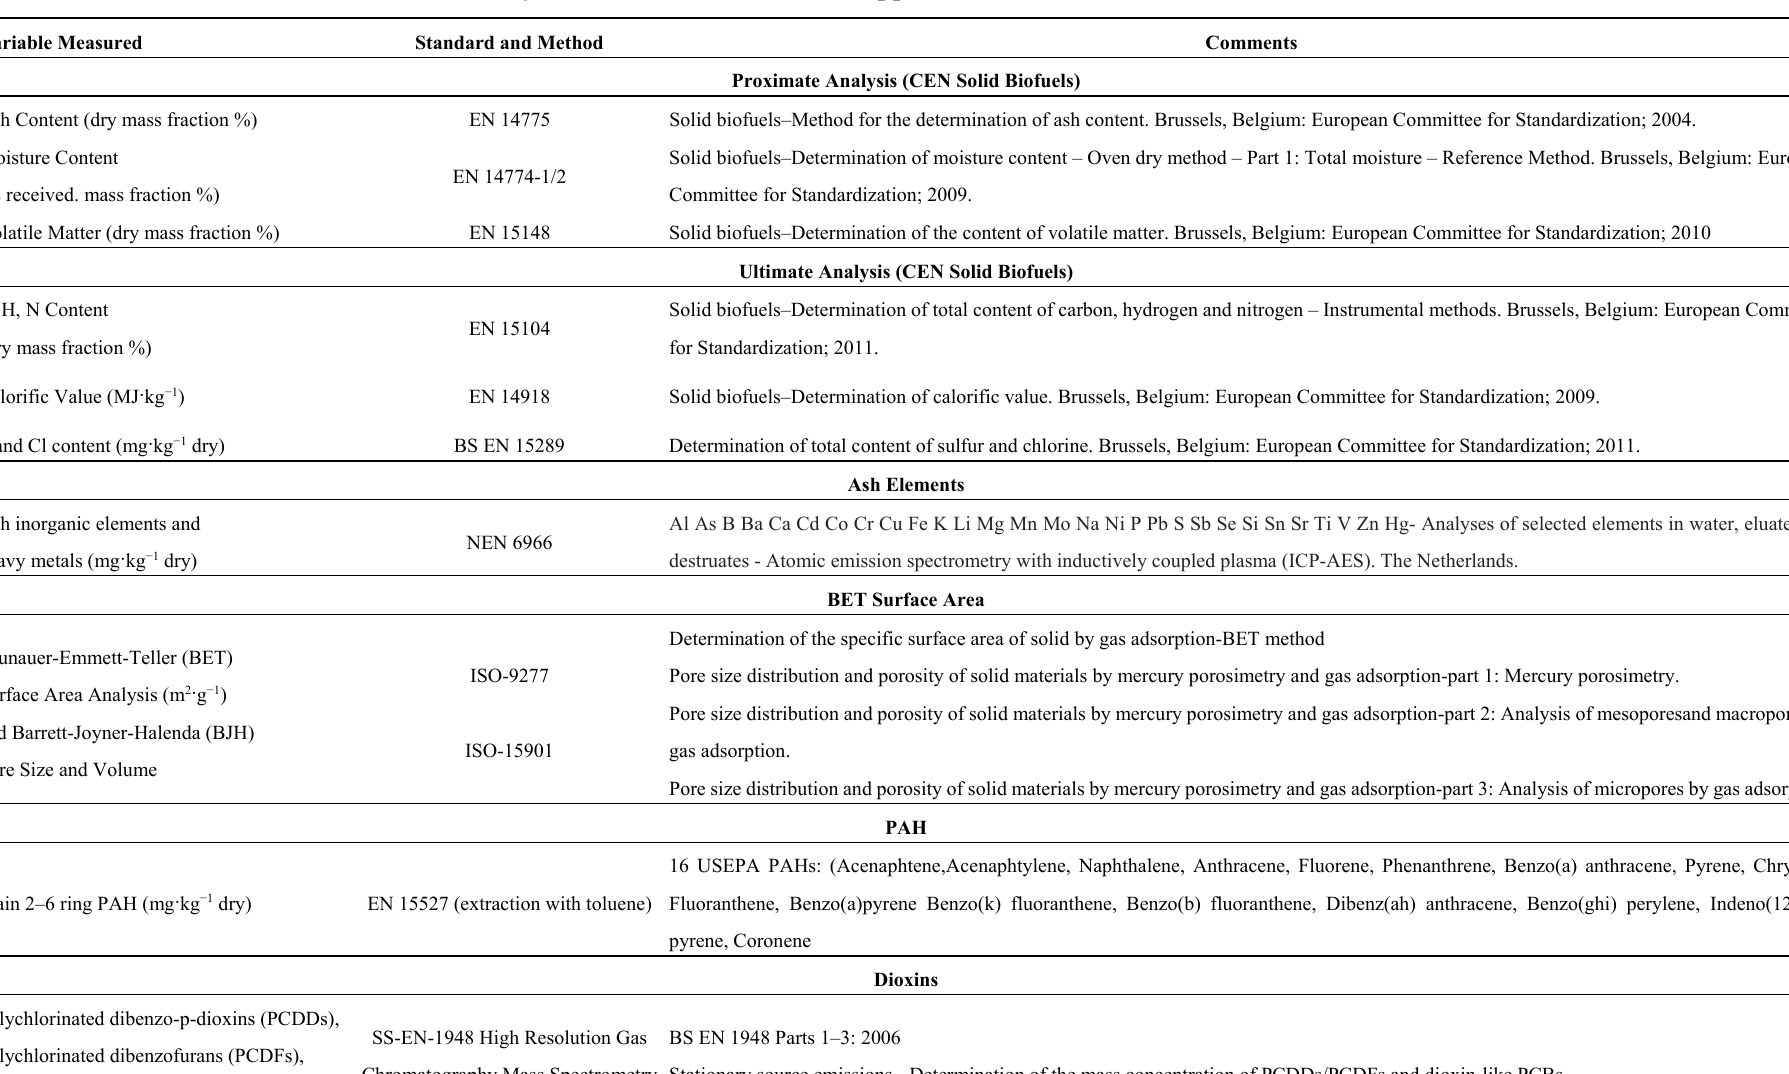
Table 2. Set of analysis, standards and methods applied at ECN for the characterization of the